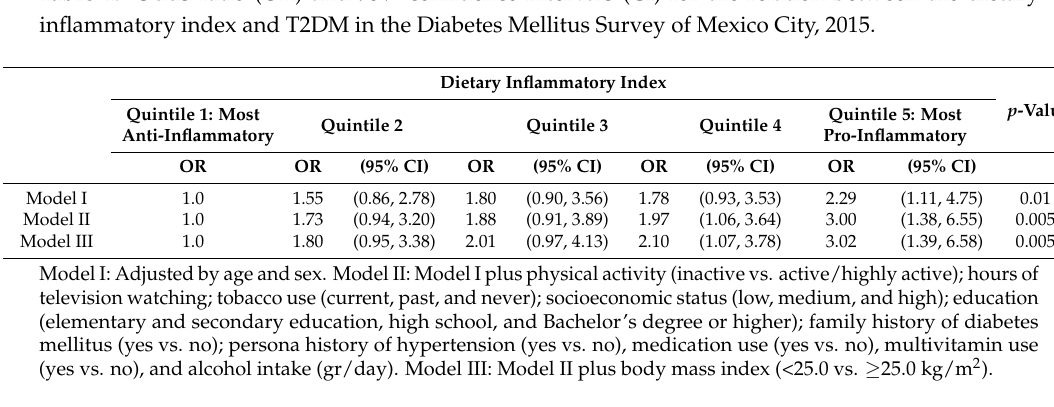
p -ValueQuintile 1: Most Quintile 5: Most Pro-Inflammatory